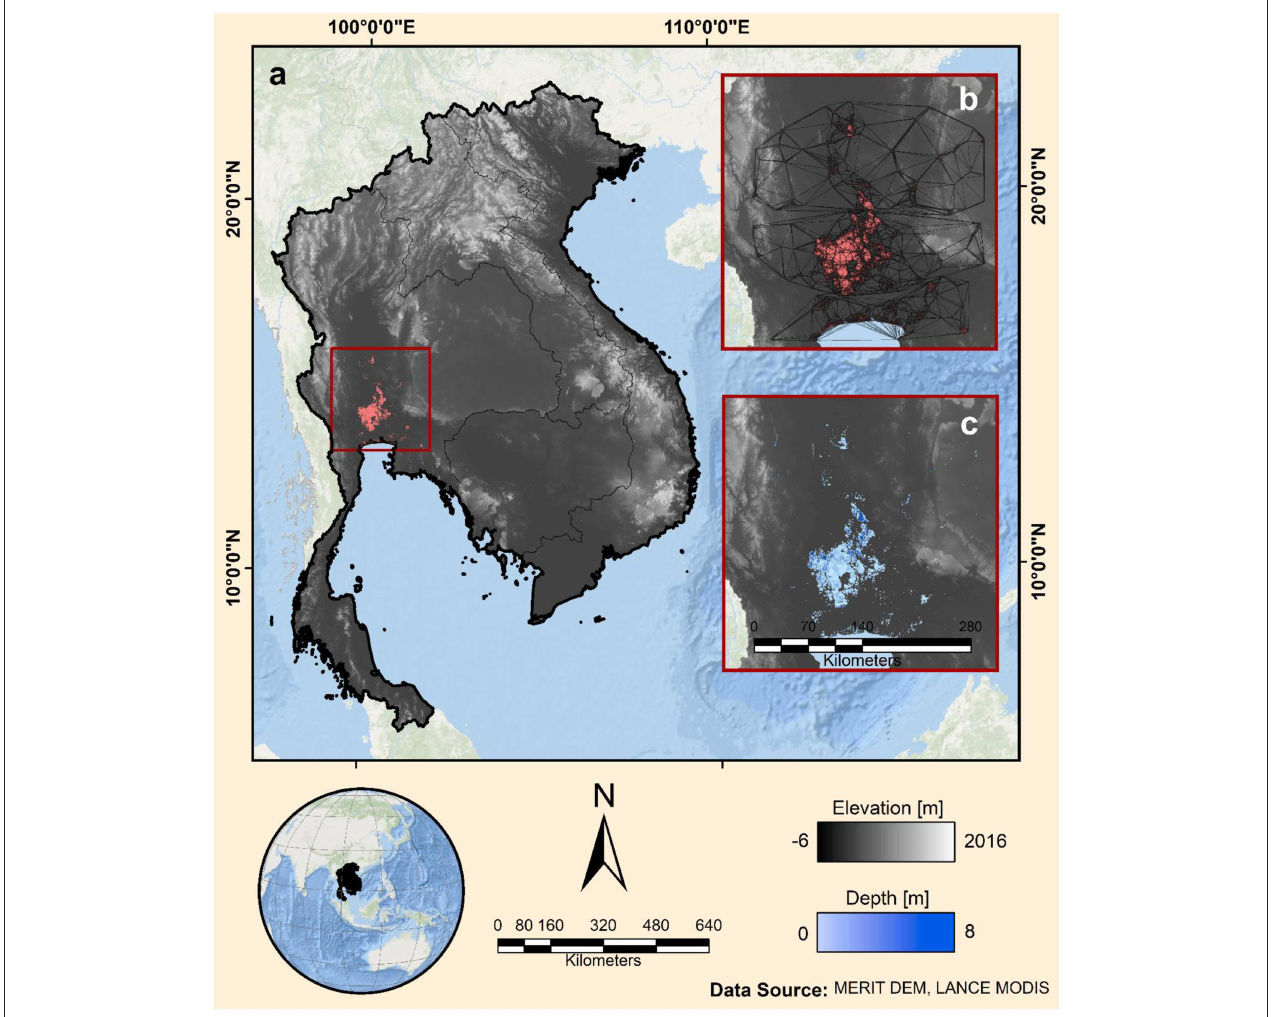
FIGURE 1 | (a) Map of Lower Mekong River Basin countries with flood extent from 2011 event (pink shaded region). (b) Study extent showing results of the triangular interpolated network (TIN) produced by extracting land elevations from around the perimeter of the flood extent. (c) Resulting inundation depth raster produced by flood impact